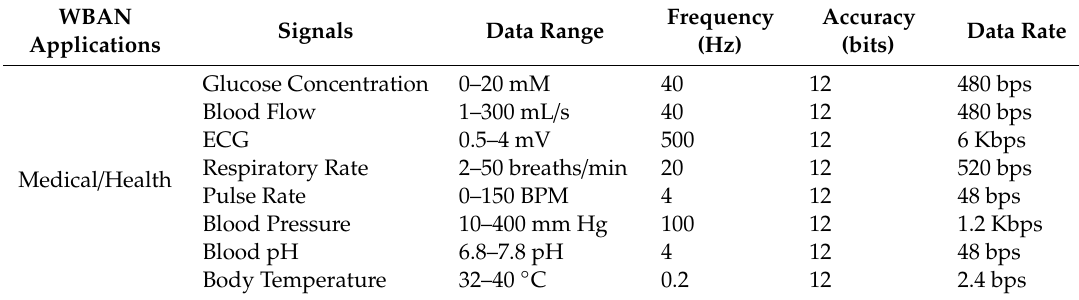
Table 1. WBAN Application Operating Range [8].